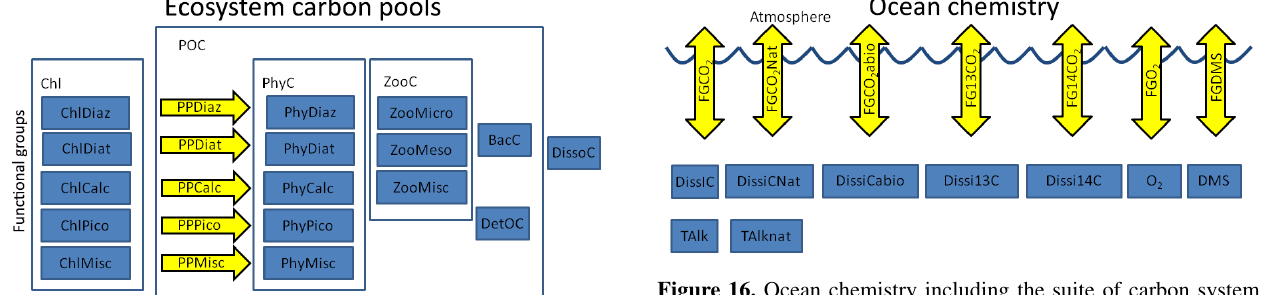
Figure 16. Ocean chemistry including the suite of carbon system tracers and those undergoing gas exchange.